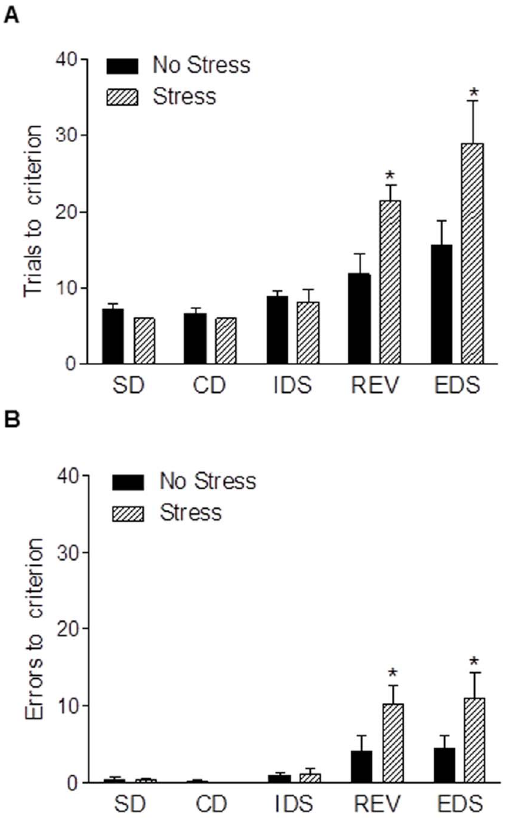
Figure 4. Chronic gestational stress impairs cognitive flexibil- ity. Compared to postpartum females who were unstressed, postpar- tum females stressed in pregnancy showed impairments on the reversal (REV) and extra dimensional (EDS) phases of the attentional set shifting task as demonstrated by more trials (a) and errors (b) to reach criterion. The number of trials (a) and errors (b) to reach criterion for the simple discrimination (SD), compound discrimination (CD) and intradimen- sional shift (IDS) did not differ between unstressed and stressed mothers. Bars represent mean 6 SEM, * p , 0.05.